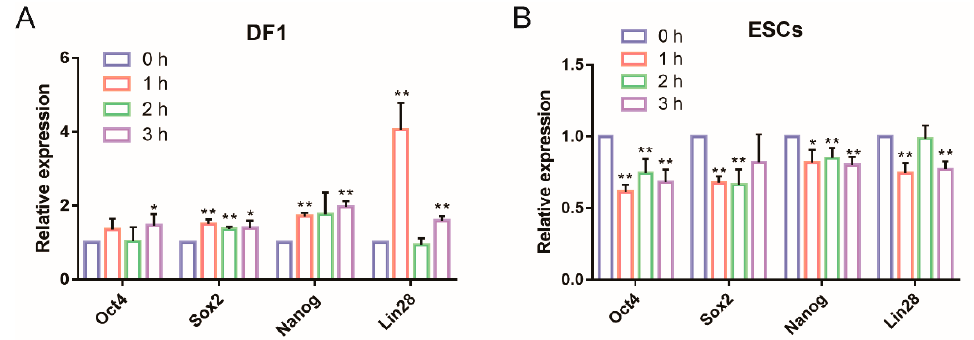
Figure 4. Glycolysis activates the expression of pluripotent genes. ( A ) qRT-PCR analysis of expression of pluripotent genes Oct4 , Sox2 , Nanog and Lin28 after adding glycolytic activator DASA-58 to DF-1. ( B ) qRT-PCR analysis of expression of pluripotent genes Oct4 , Sox2 , Nanog and Lin28 after adding glycolytic inhibitor VK3 to ESCs. * represents p < 0.05 and ** represents p < 0.01.